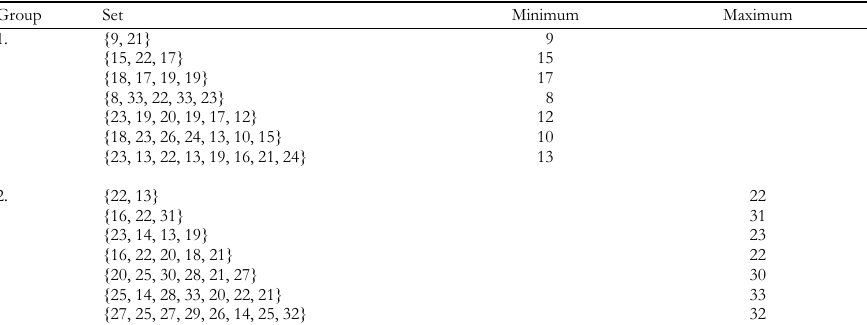
Illustration of MRSS for the Grassland Biodiversity